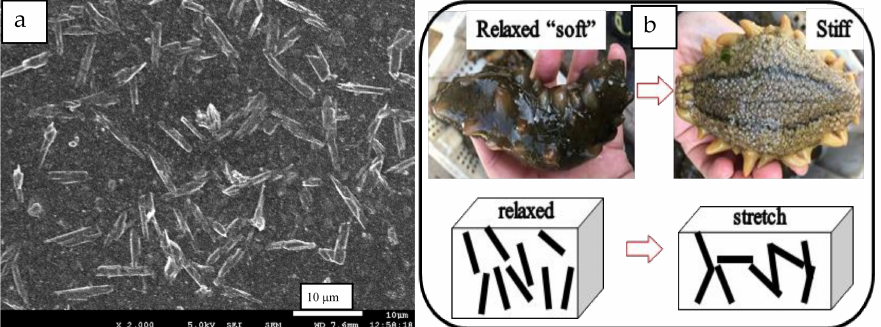
Figure 7. ( a ) SEM image of RRC dispersed in the NR matrix; ( b ) schematic diagram of the RRC networks formed under